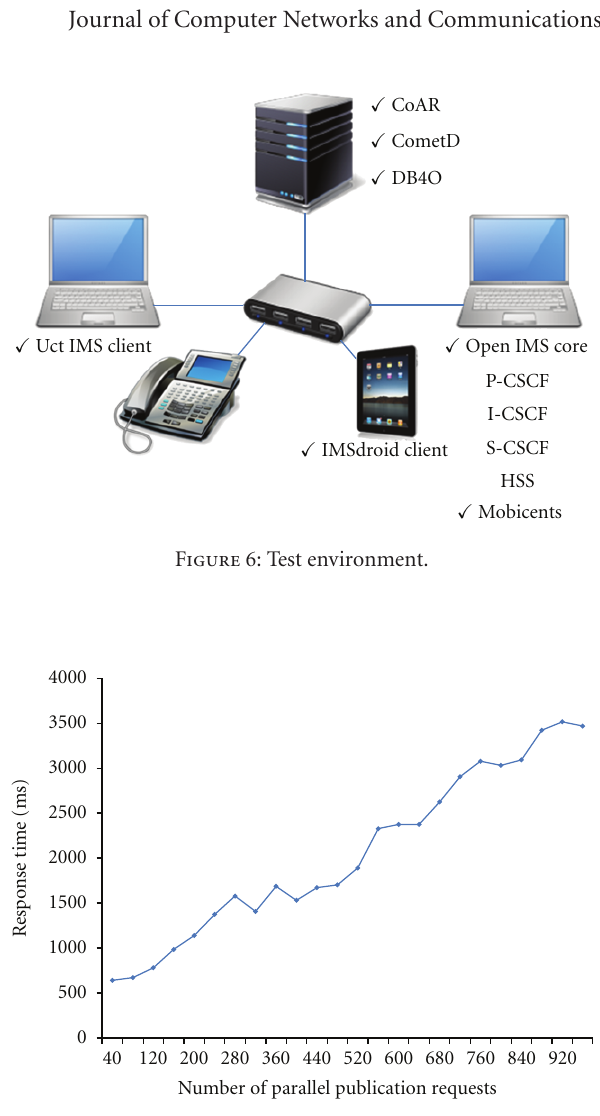
Figure 7: Response time variation according to number of publica- tion requests.